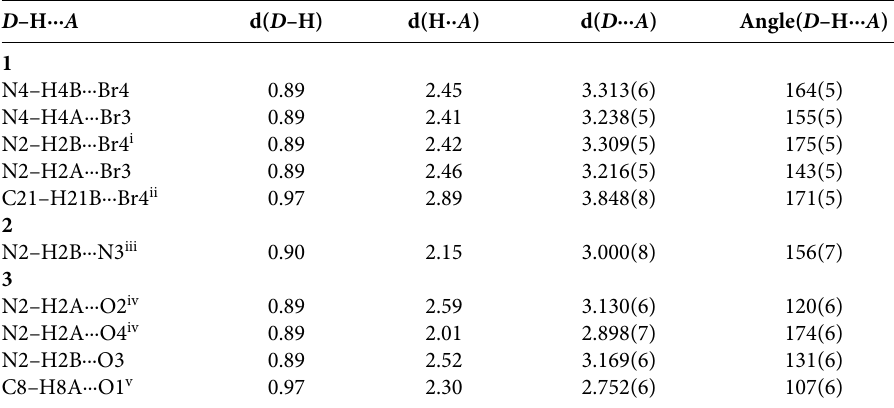
Table 3 . Distances (Å) and angles (°) involving hydrogen bonding of the complexes